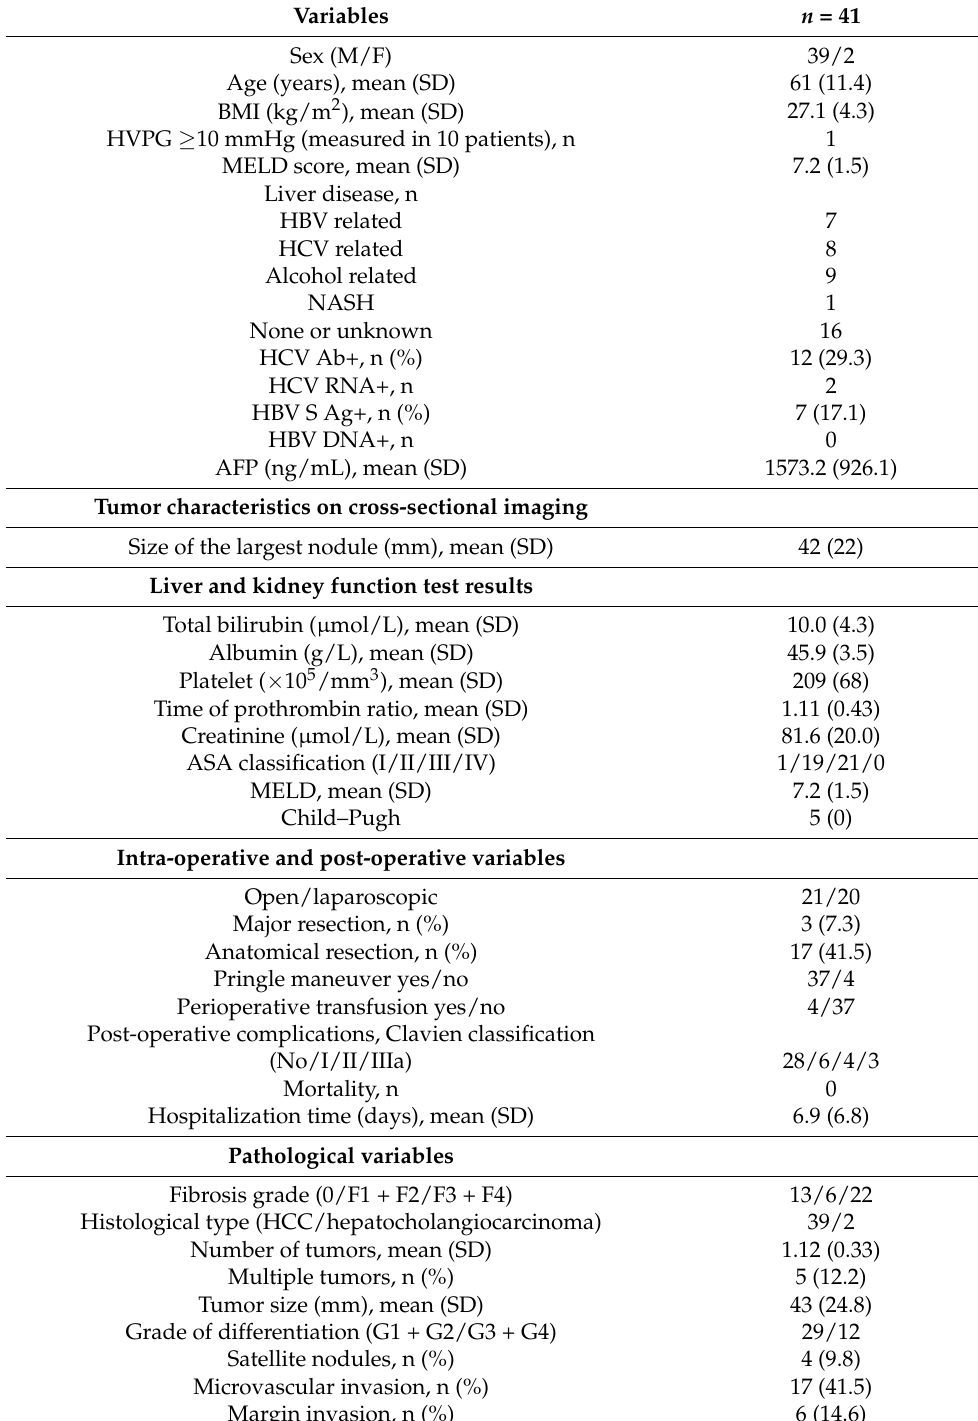
Table 1. Characteristics of the study